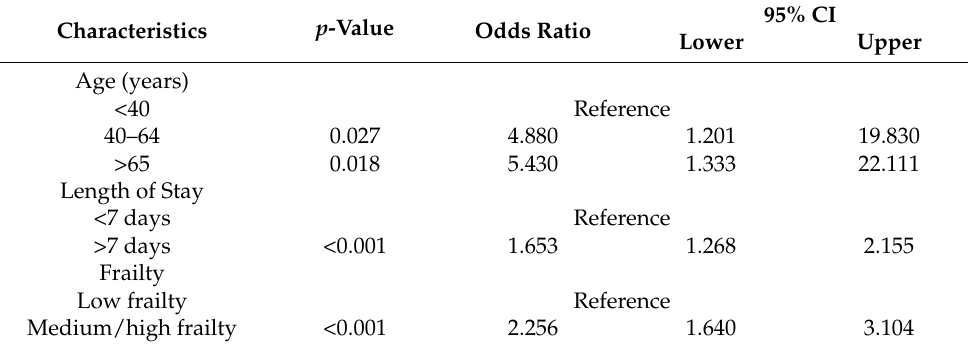
Table 3. Logistic regression model showing the effect of frailty on the risk of hepatic